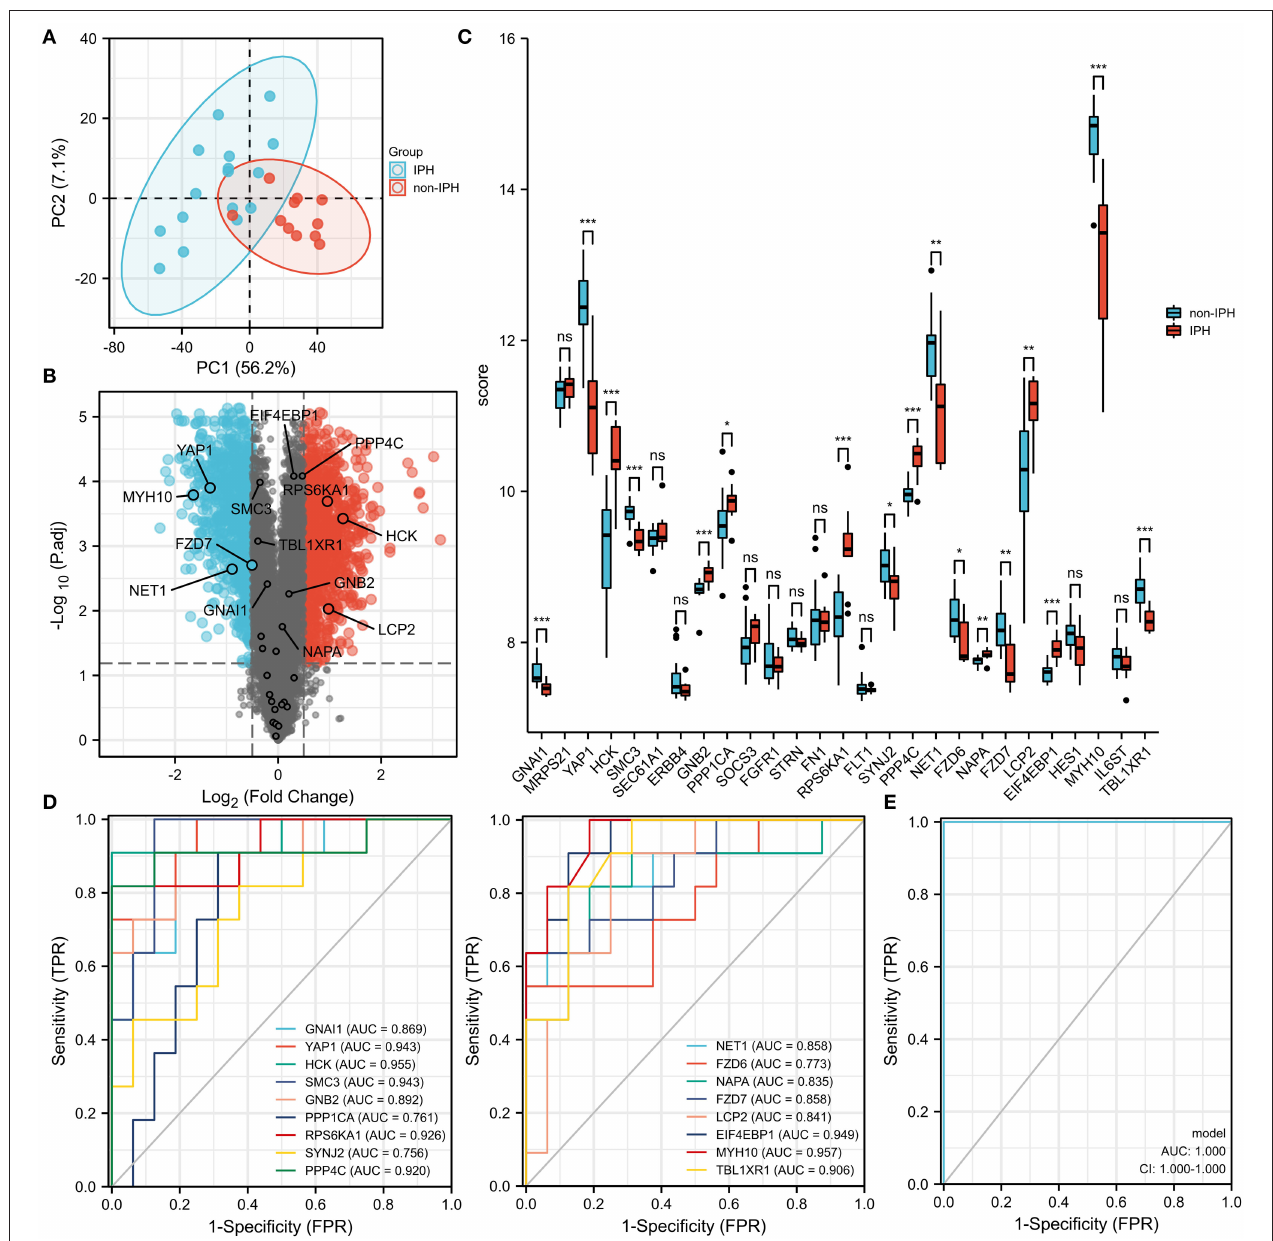
FIGURE 5 | Expression patterns of the hub differentially expressed macrophages-related genes (DEMRGs) were validated in the GSE163154 dataset. (A,B) The principal components analysis (PCA) diagram (A) and Volcano plot (B) between the patients with intraplaque hemorrhage and non-intraplaque hemorrhage. (C) The expression level of the hub DEMRGs. (D) The receiver operation characteristic (ROC) curves of the hub DEMRGs validated in the patients with intraplaque hemorrhage compared to control. (E) The joint ROC curves of the hub validated DEMRGs. IPH, intraplaque hemorrhage. * p < 0.05; ** p < 0.01; *** p < 0.001; ns, not